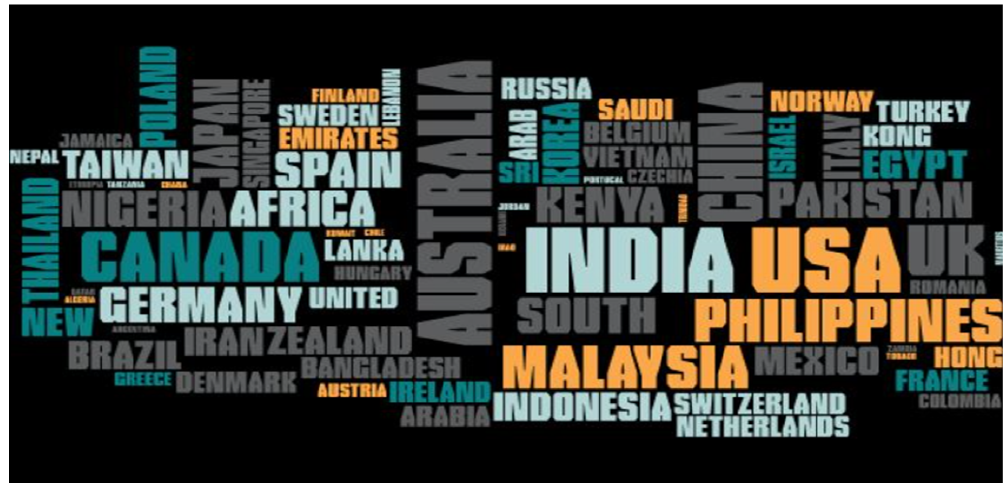
Figure 5. Word cloud of phytohormone search countries in the Google. The word cloud shows the most phytohormone search countries of the world. It includes India, the USA, United Kingdom, the Philippines, Australia, Kenya, Canada, and others. The word cloud was generated using the Google trend search for phytohormones for different countries.